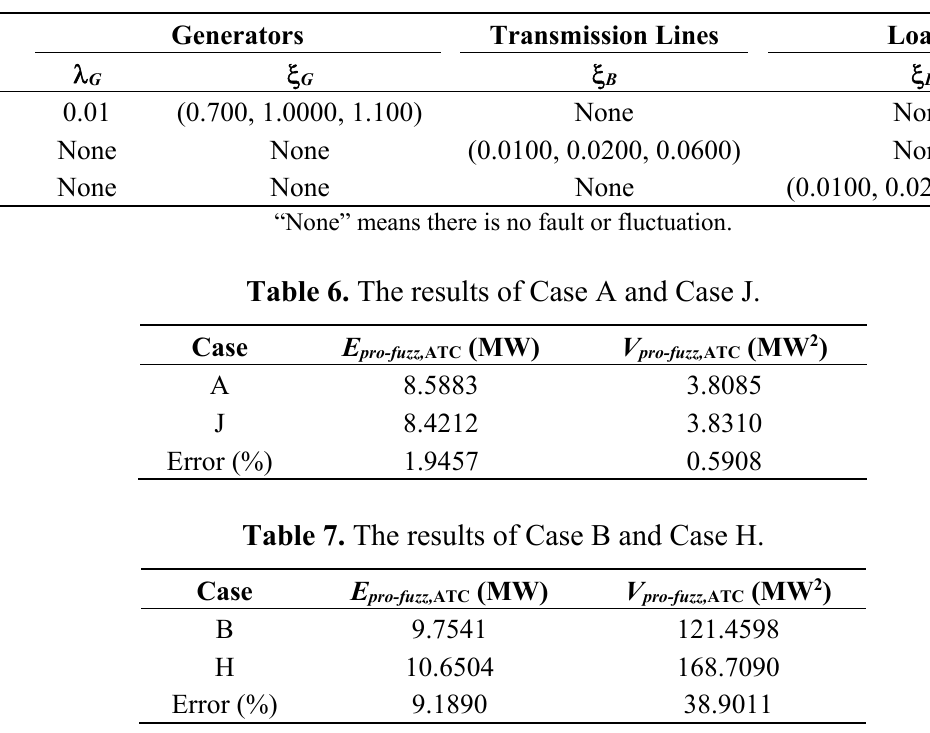
Table 5. The parameters of generators, transmission lines and loads for Cases J–I.